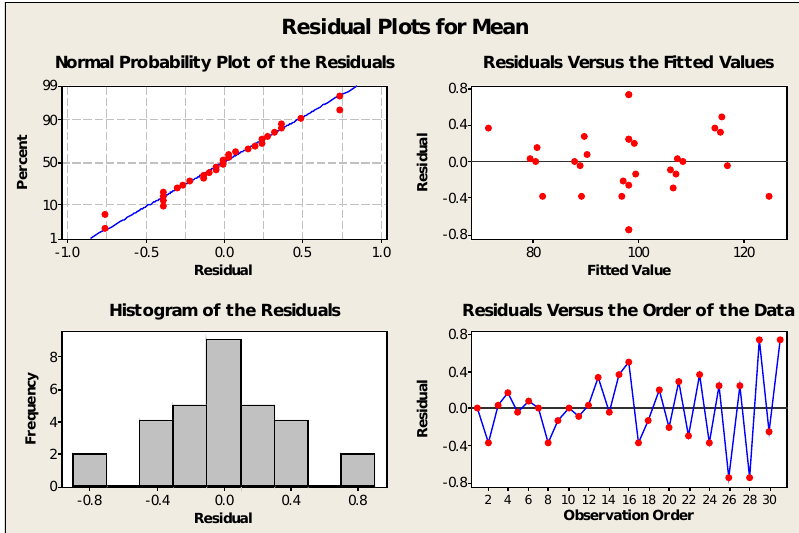
Fig. 1. Residual plots for thickness